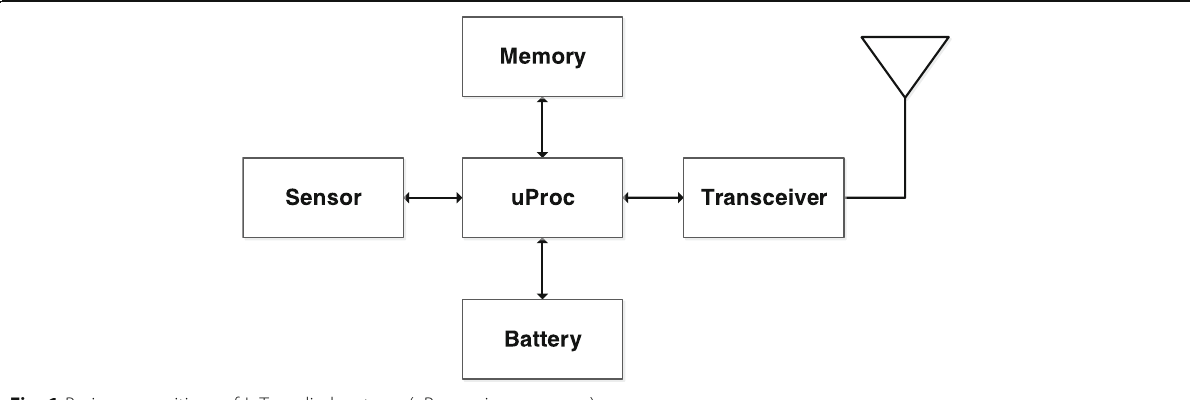
Fig. 1 Basic compositions of IoT applied systems (uProc, microprocessor)